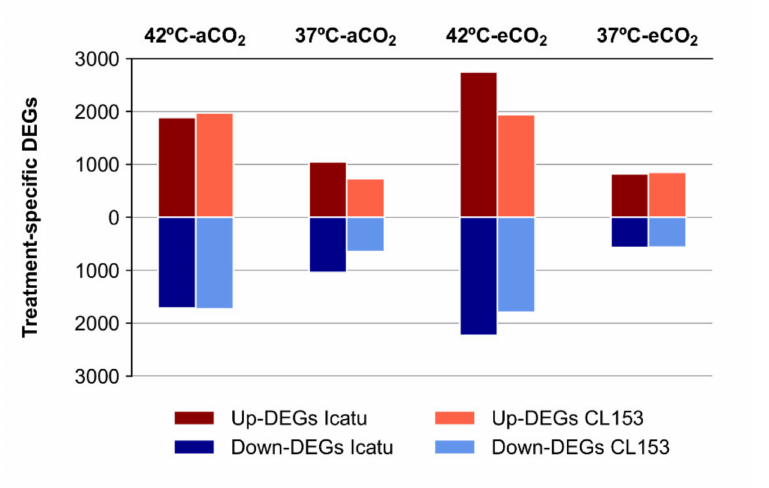
Figure 3. The effect of the supra-optimal temperatures 37/28 ◦ C (37 ◦ C) and 42/30 ◦ C (42 ◦ C) on the number of up- and down-regulated treatment-specific DEGs in plants of Icatu and CL153, grown in either 380 µ L L − 1 aCO 2 or 700 µ L L − 1 eCO 2